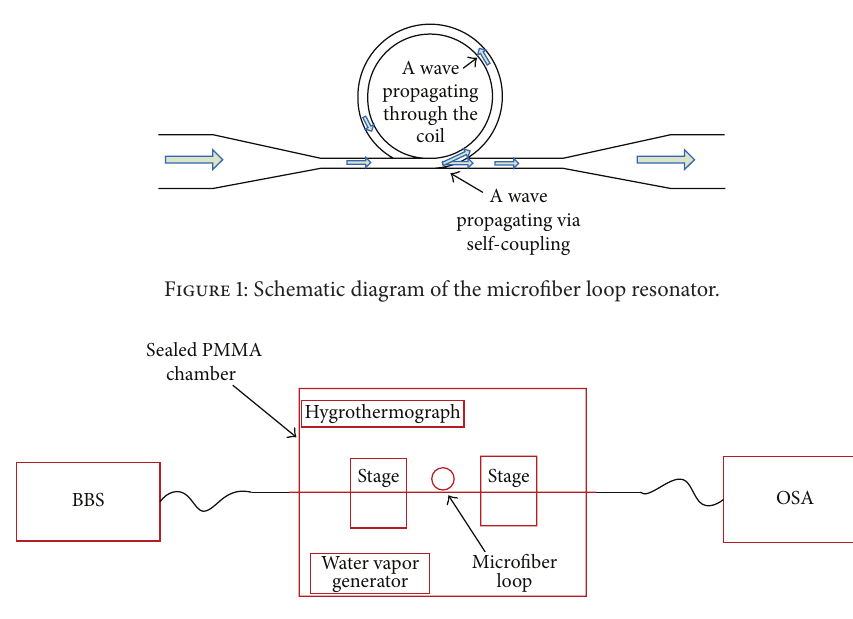
Figure 2: The relative humidity measurement system. BBS: broadband light source: OSA, optical spectral analyzer.